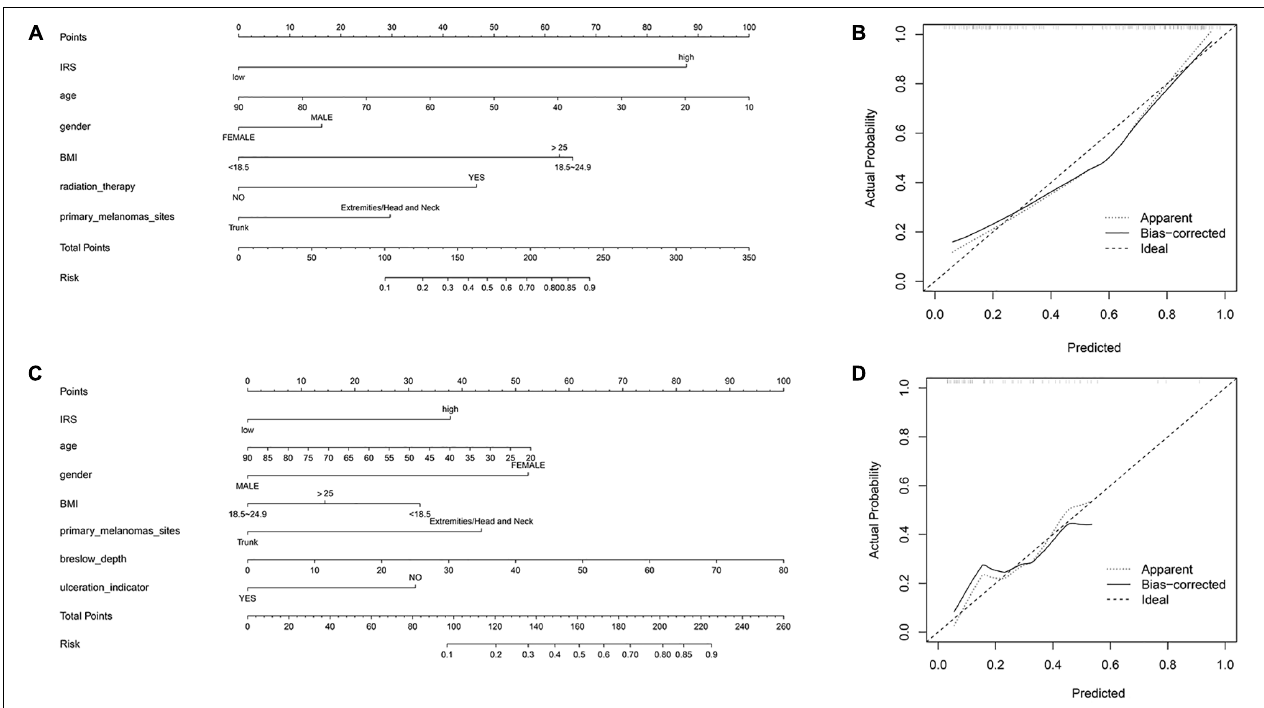
FIGURE 3 | Construction of nomogram. (A) Nomogram for predicting melanoma metastasis for the sequencing samples. (B) Calibration curves of nomograms in terms of agreement between predicted and observed in the sequencing samples. (C) Nomogram for predicting melanoma metastasis for the initial diagnosis patients. (D) Calibration curves of nomograms in terms of agreement between predicted and observed in the initial diagnosis